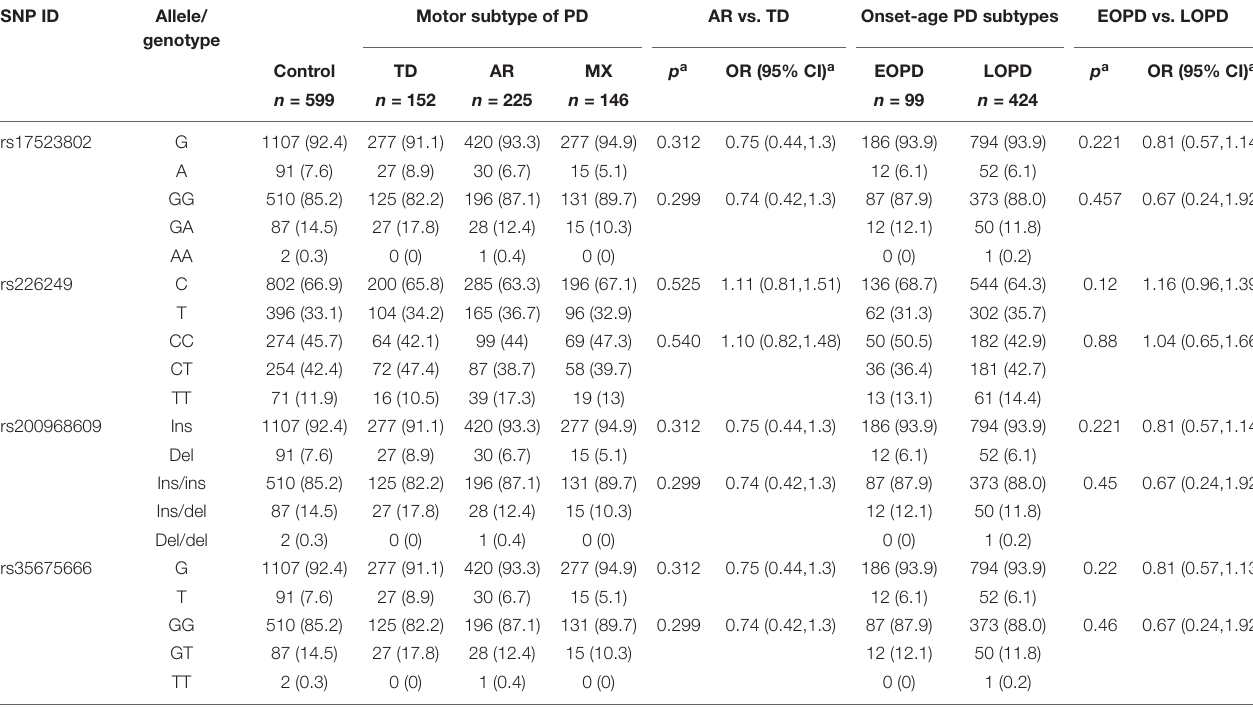
TABLE 3 | Allele distribution of DJ-1 promoter polymorphisms between controls and different PD subtypes classified by motor features or age at onset. SNP ID Allele/ Motor subtype of PD AR vs. TD Onset-age PD subtypes EOPD vs. LOPD genotype